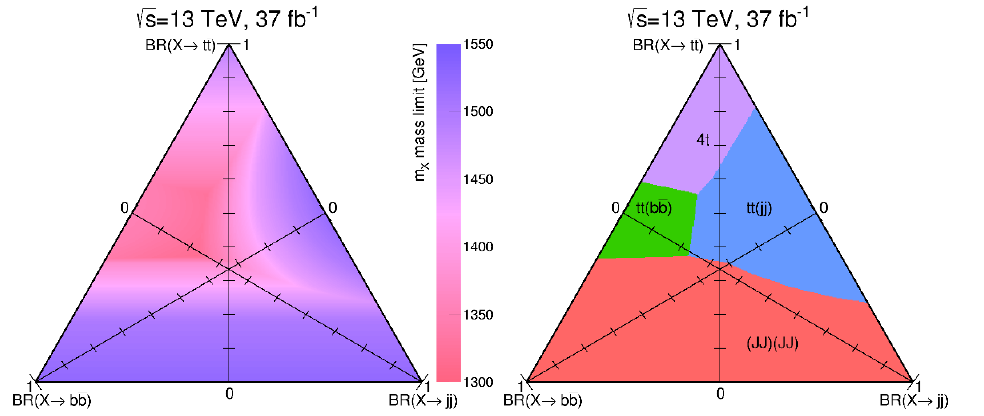
Figure 3 . Left: strongest mass limits when the various t (cid:22) t , b (cid:22) b , and jj decay channels are compared. Right: search region that gives the best